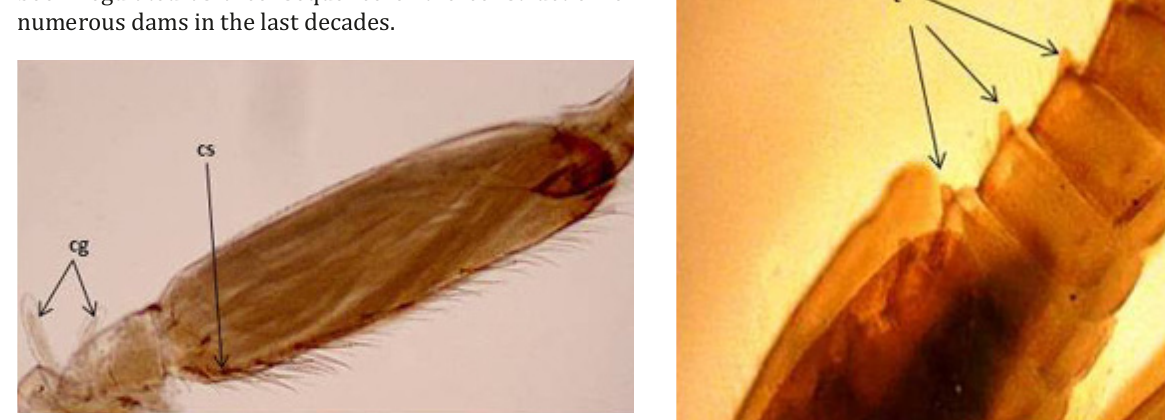
B. huaico Figure 3. Nymph of . (cg) coxal gills; (cs) clavate setae of dorsal edge of femora I.